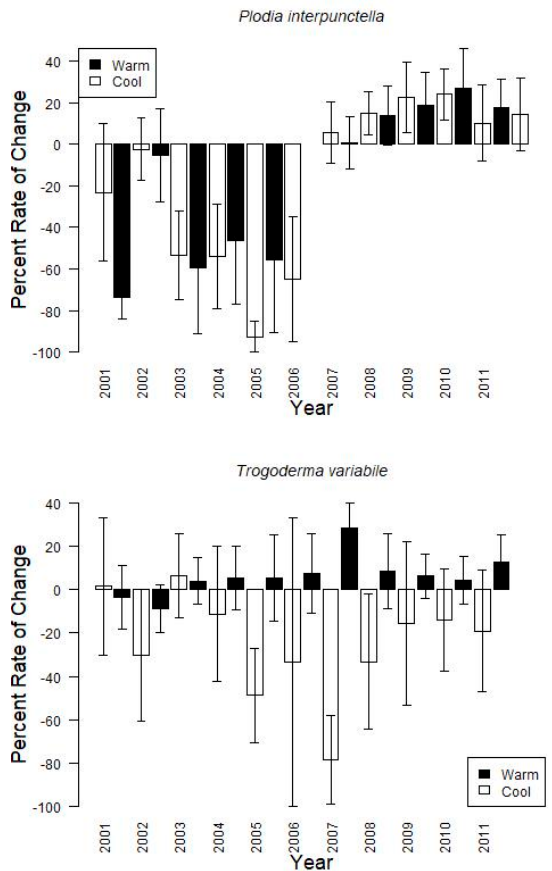
Figure 3. Bar graphs of the average rate of change from one trapping period to the next for each species based on indoor insect captures. The cool season is represented by white bars and warm season is the black bars. Each year is represented on the x-axis and the percent of change is on the y-axis. Error bars are standard errors.